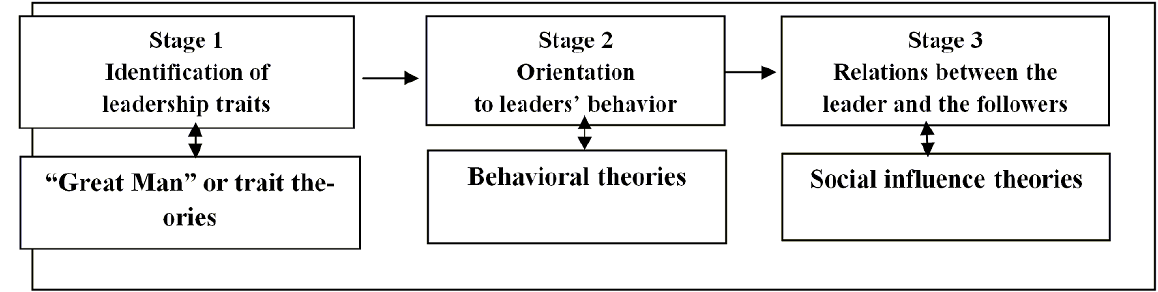
Fig. 1. Stages of scientific development of leadership (Valuckiene, et. al.,